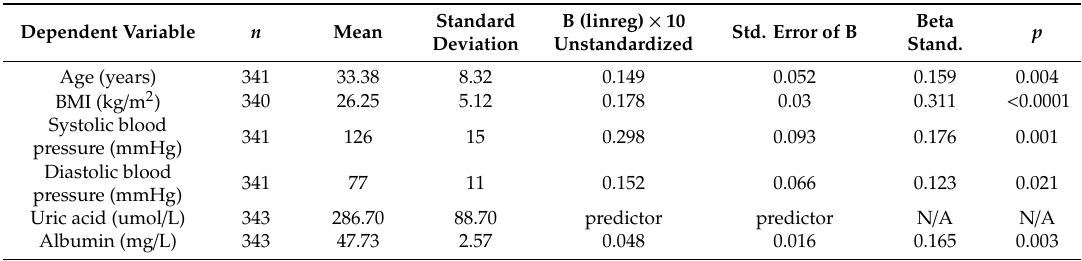
Table 6. Relationship between uric acid adjusted for age and sex and dependent variables in